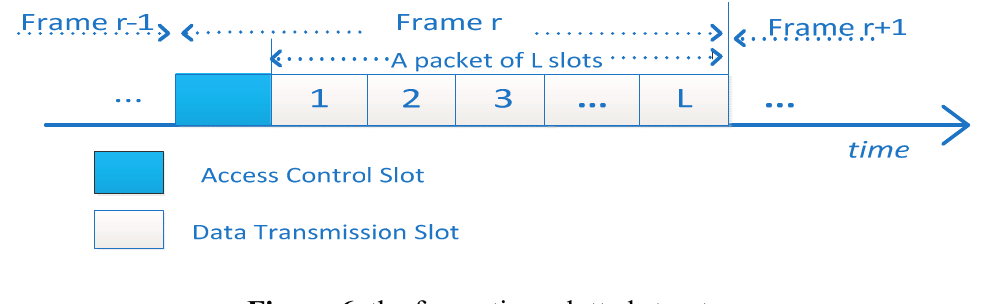
Figure 6. the frame time-slotted